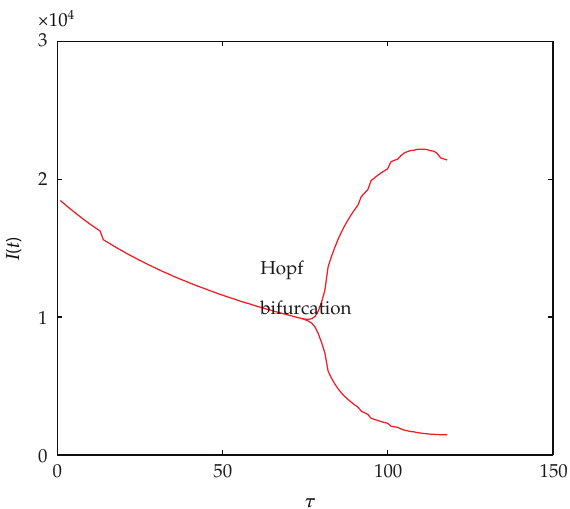
Figure 10: Bifurcation diagram of system (cid:5) 2.1 (cid:6) with τ from 1 to 120 with quarantine